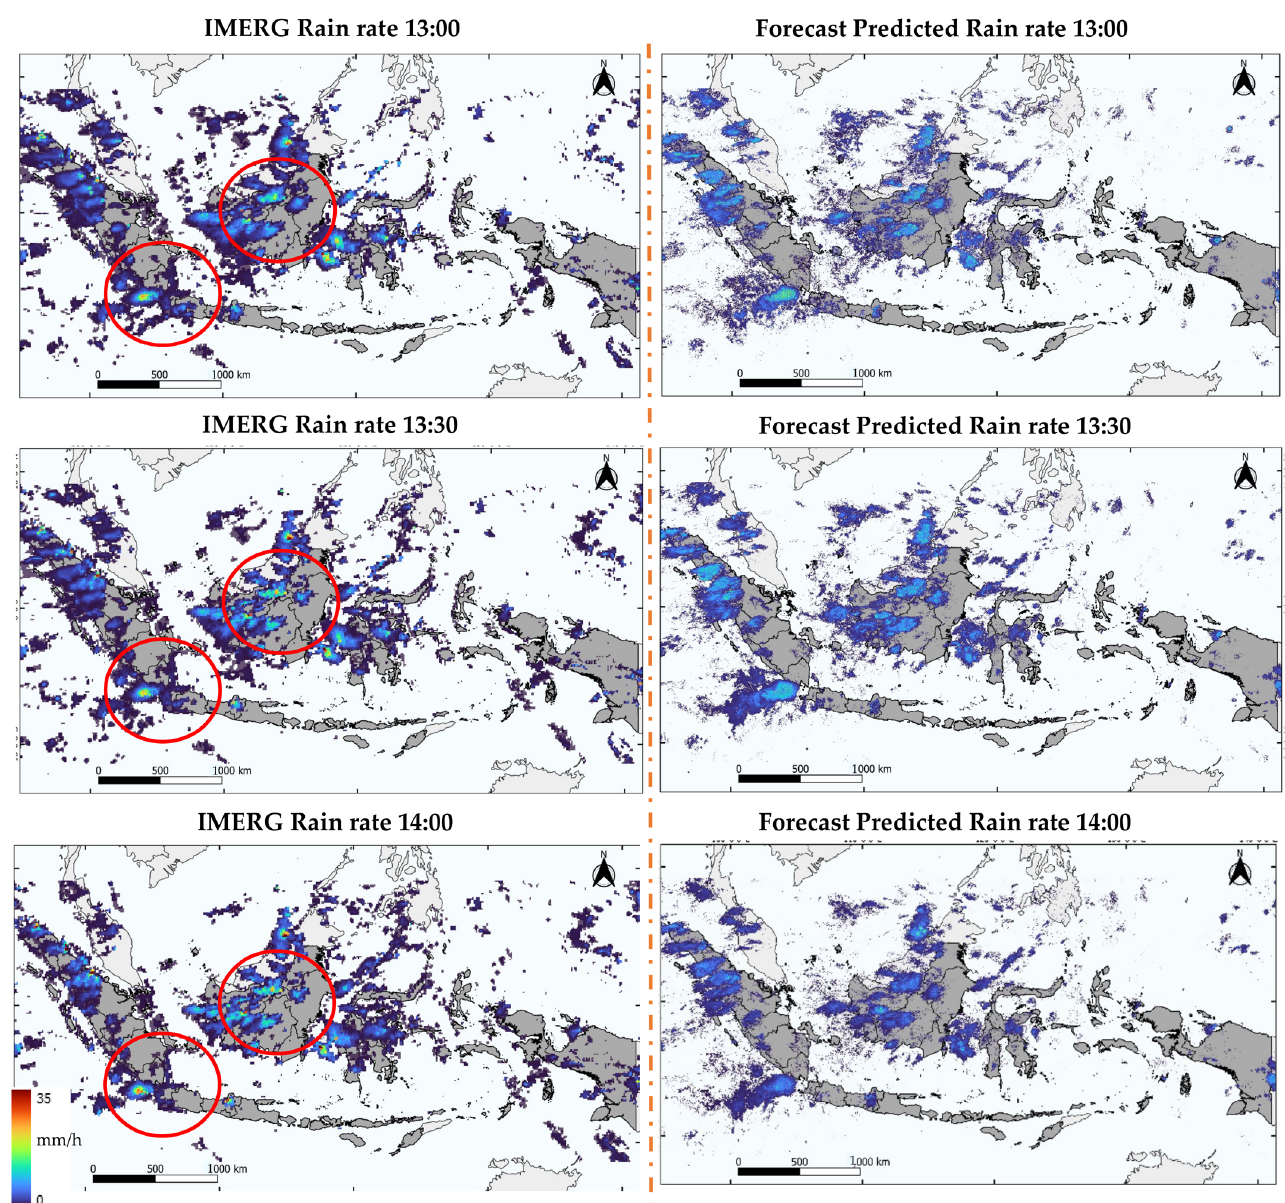
Figure 6. The visual comparison between IMERG data as the ground truth and forecast predicted rain rate value.